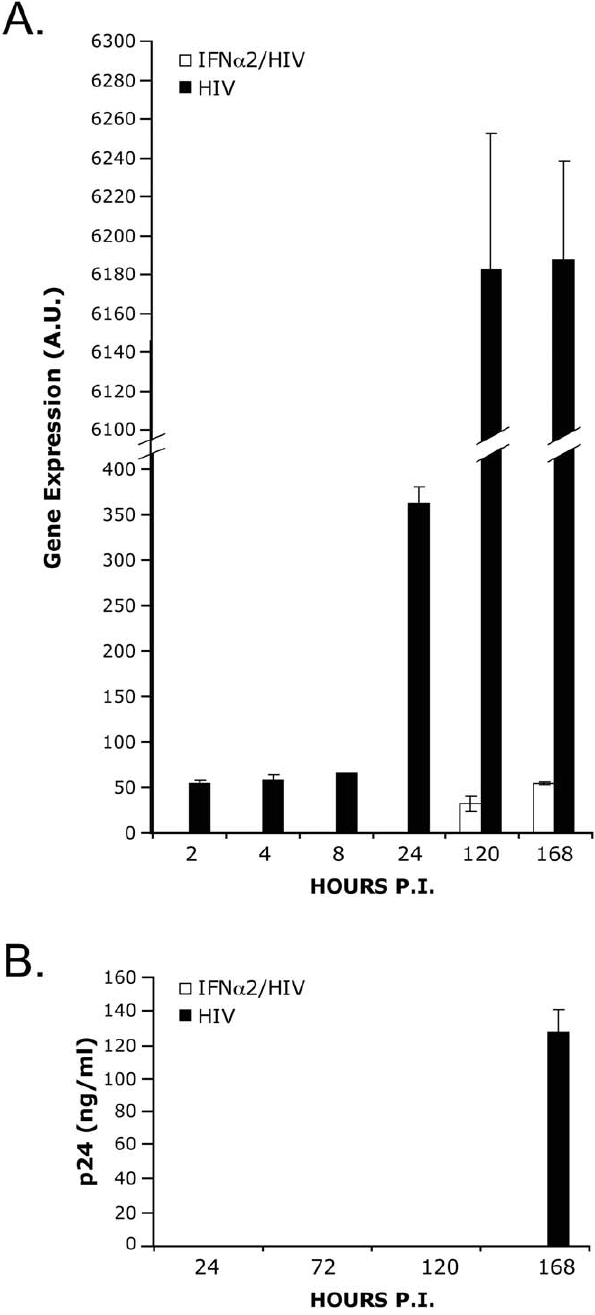
Figure 1. Type I IFN a 2 inhibits HIV-1 replication in primary macrophages. A) Gene expression of TAT spliced at 2, 4, 8, 24, 120